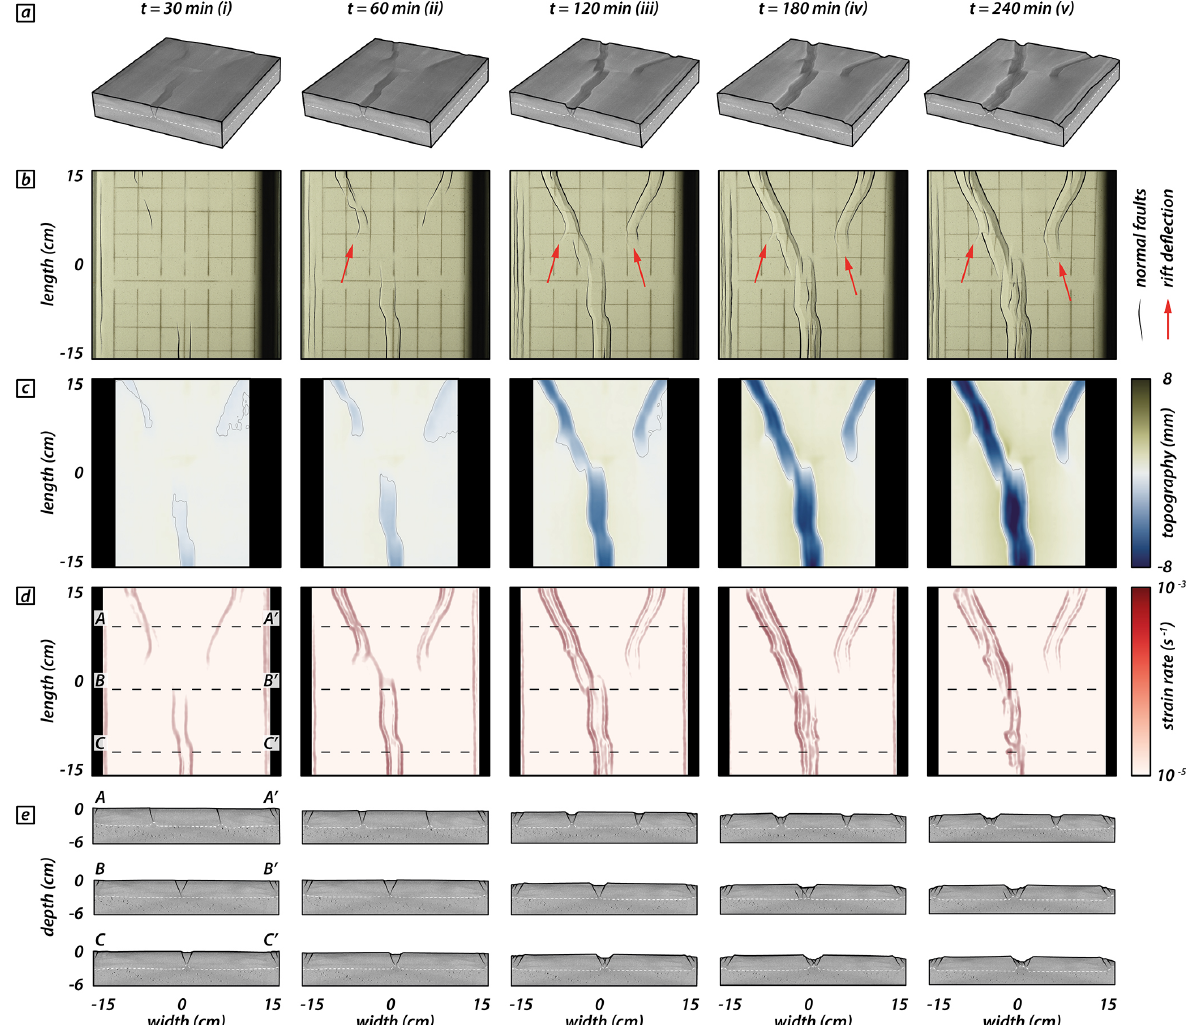
Figure 3. Analog modeling results documenting deflection of the right rear segment and cessation of faulting activity. Distinct time steps (i.e., after 30min and after every hour) show the model evolution. (a) X-ray computed tomography volumes of the investigated model domain at distinct time steps. White dashed lines indicate the brittle–viscous interface. (b) Top views and line drawings indicating observable normal faults at the model surface. Red arrows indicate rift tips that deflect and turn away from one another. (c) Topography from digital elevation models of the model surface. Color map from Crameri et al. (2020). (d) Strain rates obtained from 3D stereo DIC. Black dashed lines indicate positions of three transects through the X-ray computed tomography volume. (e) Rift transects A-A (cid:48) , B-B (cid:48) , and C-C (cid:48) . White dashed lines indicate the brittle–viscous